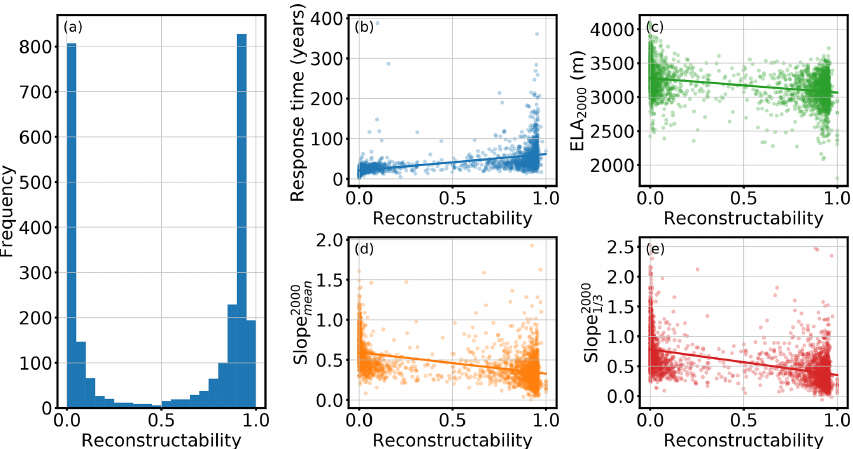
Figure 10. Reconstructability measure. (a) Histogram of the reconstructability measure of all 2660 glaciers. (b–e) Scatter plots with linear regression. The x axis always shows the reconstructability measure. The y axis shows (b) the e -folding response time ( n = 2149), (c) the equilibrium line altitude in 2000 ( n = 2660), (d) the mean surface slope in 2000 ( n = 2660), and (e) the mean surface slope of the last third of the glacier in 2000 ( n =